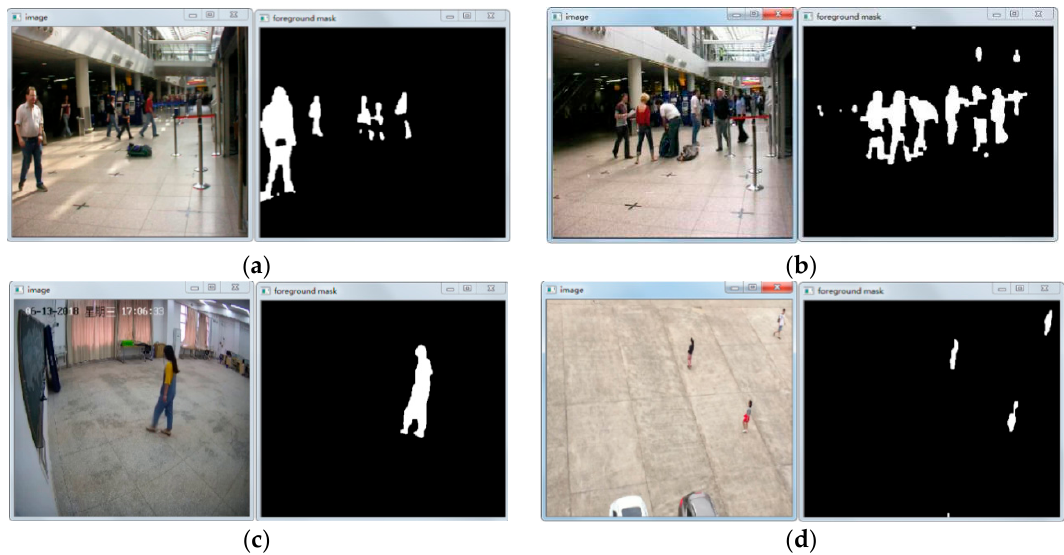
Figure 10. Gaussian mixture model (GMM) model foreground detection. ( a – b ) The detection effect of PETS 2007 dataset. ( c – d ) The results of our collected dataset include outdoor and indoor scenes.